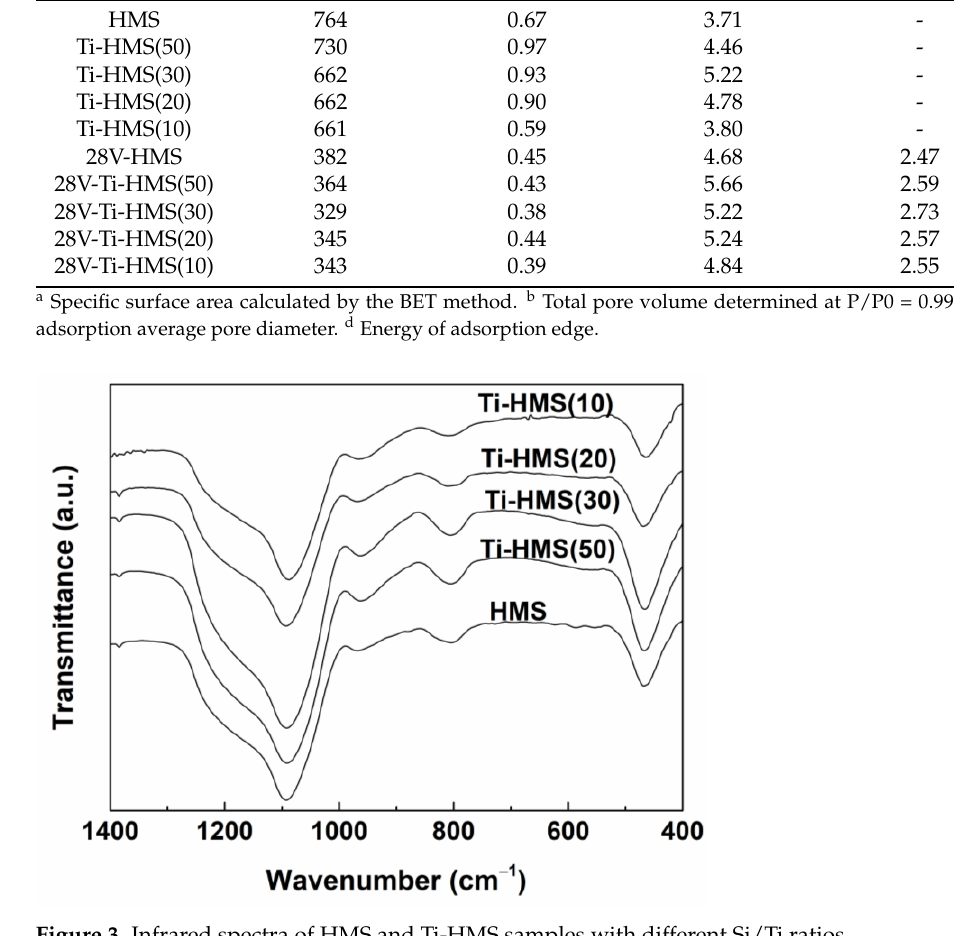
Figure 3. Infrared spectra of HMS and Ti-HMS samples with different Si/Ti ratios.